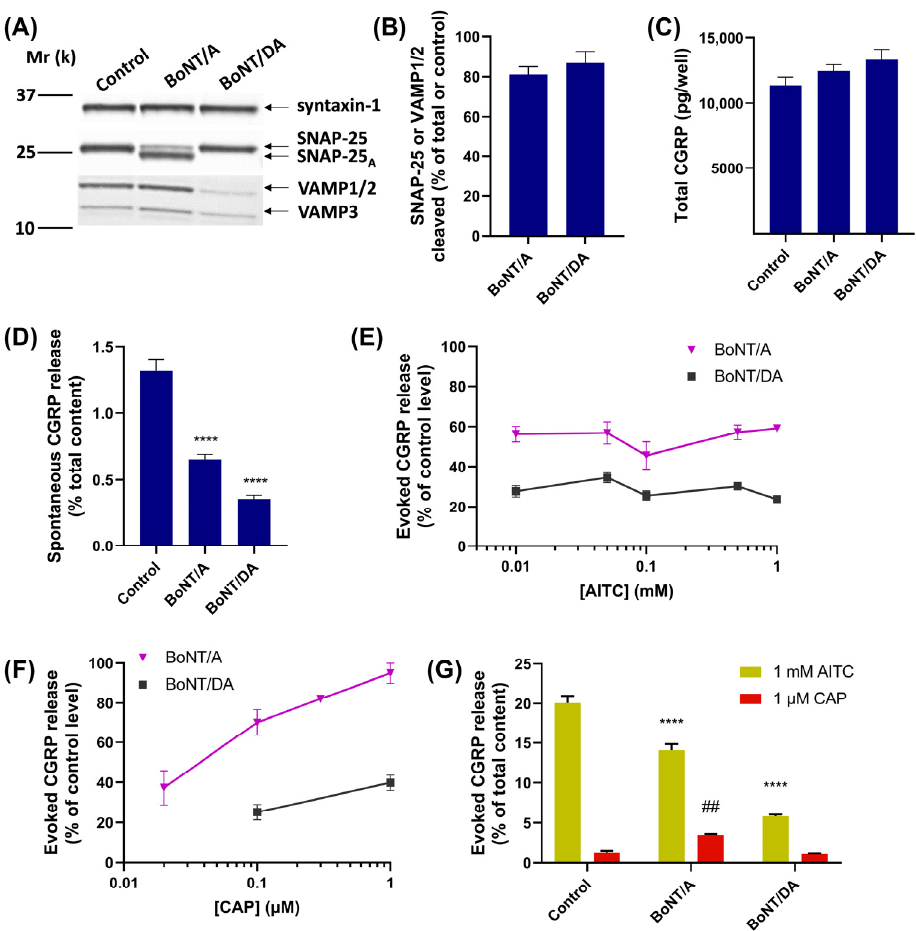
Figure 5. VAMP-cleaving BoNT/DA inhibits AITC- and CAP-evoked CGRP releases from TGNs more extensively than BoNT/A, which proteolyses SNAP-25. Cultured TGNs were pre-treated with 100 nM BoNT/A, BoNT/DA, or control medium for 48 h, before determining spontaneous and evoked CGRP release over sequential 30 min periods. At the end of each experiment, a cohort of cells was lysed in SDS-PAGE sample buffer and subjected to Western blotting with a mixture of three different antibodies recognising syntaxin-1 (isoforms A and B), SNAP-25 (both intact plus cleaved forms), and VAMP (isoforms 1, 2, and 3), respectively (see Section 4 for details). ( A ) Representative Western blots show that BoNT/A cleaved SNAP-25, whereas BoNT/DA proteolysed and, thereby, diminished detectable VAMPs 1/2, and 3 (note that VAMPs 1 and 2 co-migrate). Syntaxin-1 is not affected by either of the toxins, so it was used as a loading control. ( B ) The fractions of SNAP-25 or VAMP1/2 cleaved were quantified by densitometric analysis (as described in Section 4); N = 5, n = 5. Note that the weak VAMP3 signals were not analysed. ( C ) The total content of CGRP (pg/well). ( D ) Histogram displaying spontaneous CGRP release, in control cells and those treated with the BoNTs, calculated as % of the total CGRP; N ≥ 3, n = 16. ( E ) CGRP release evoked by various [AITC] for 30 min from TGNs pre-treated with BoNTs, expressed as % of requisite amounts elicited from non-intoxicated control cells; N ≥ 2, n ≥ 5. ( F ) After pre-treatment with the indicated BoNTs, TGNs were exposed to different [CAP], or ( G ) sequentially stimulated with 1 mM AITC (yellow) and then 1 µM CAP (red) for 30 min each. Evoked CGRP release is expressed as a % of control level ( F ) or in ( G ) % of the total content of this neuropeptide. Note, in ( F ) data for BoNT/A are from [41]. Data are presented as mean ± s.e.m. One- or two-way ANOVA was used in ( D ) and ( G ) followed by Bonferroni’s post hoc test; ## p < 0.01 for CAP-evoked in control vs. BoNTs; **** p < 0.0001 for AITC-evoked vs. BoNTs.